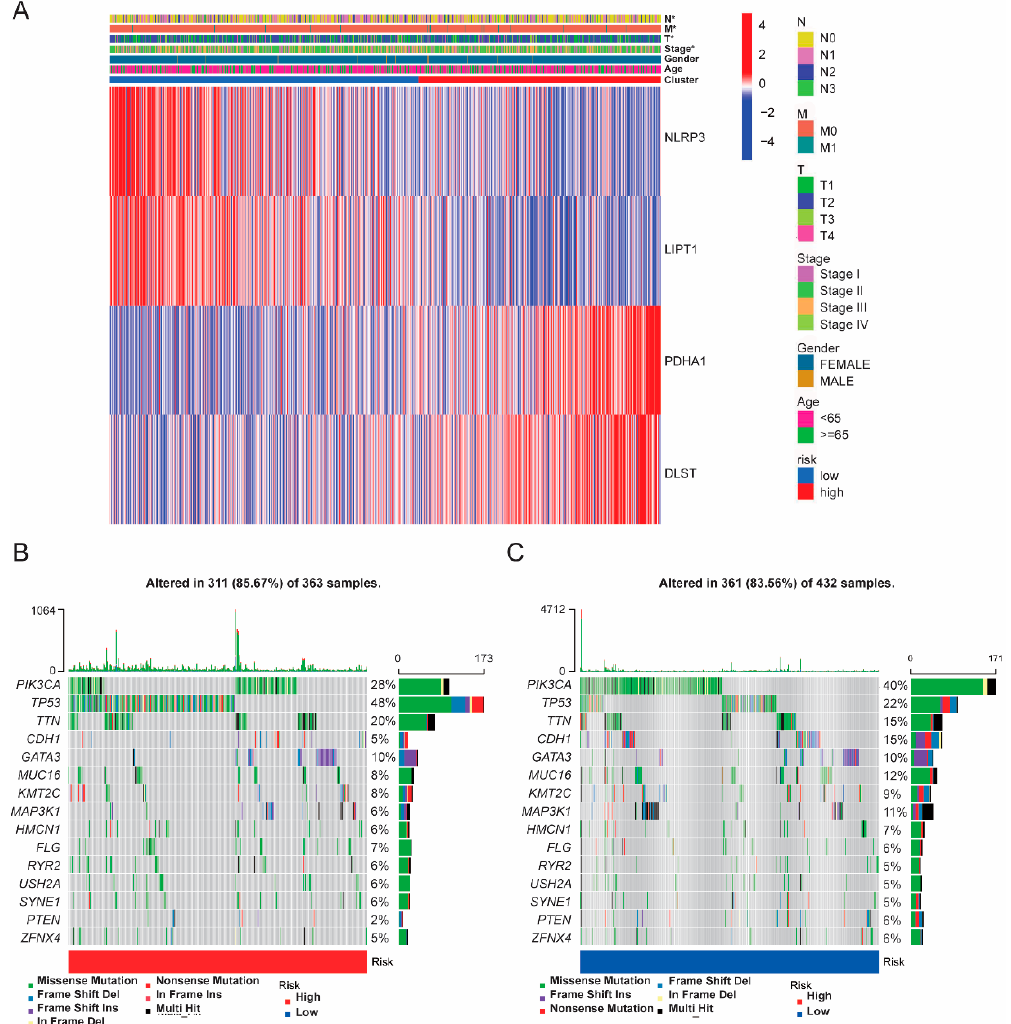
Figure 6. The cuproptosis-related DEGs and somatic mutation frequency rate among the breast cancer risk group. ( A ) Heatmap of the cuproptosis-related DEGs based on the breast cancer cluster. ( B ) Somatic mutation frequency rate based on the high-risk group. ( C ) Somatic mutation frequency rate based on the low-risk group.